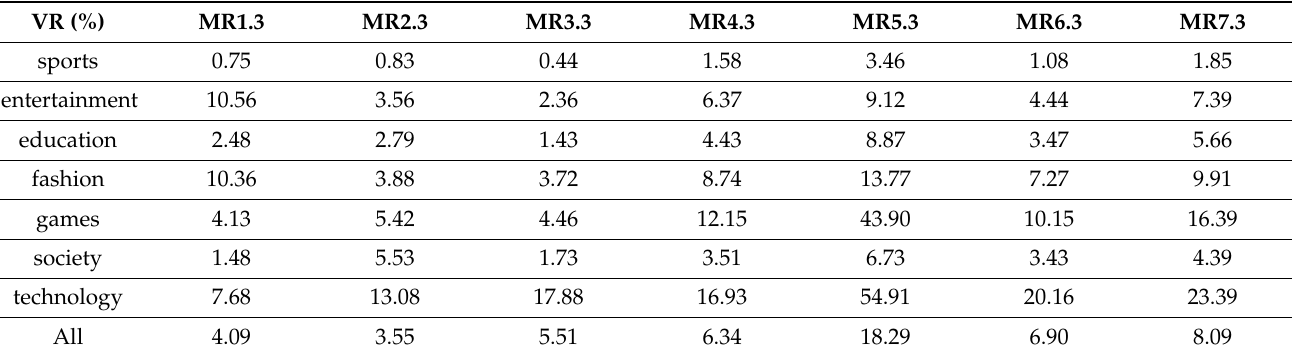
Table 10. BaiduNLP text classification results.